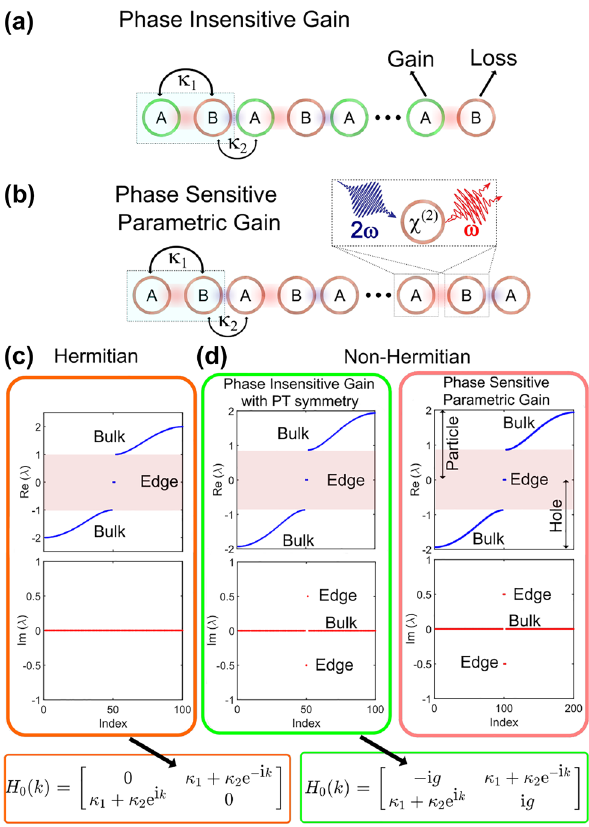
Figure 1: Topological edge-gain induced by parametric interaction. (a) Conventional topological edge-gain realized with alternate phase-insensitive laser gain and loss arrangement in a SSH chain of resonators. (b) Similar edge-gain can be implemented with uniform parametric gain in a SSH chain of nonlinear resonators, where the quadratic nonlinearity ( 𝜒 (2) ) couples the pump (2 𝜔 ) and the signal ( 𝜔 ) waves. (c) Eigenvalue diagram (real part (top) and imaginary part (bottom)) for a Hermitian SSH model showing the topologically protected edge mode lying within the bandgap. Edge-only instability is not possible in this case. (d) Eigenvalue diagram for a non-Hermitian setting realized either utilizing phase-insensitive gain (left) as shown in (a) or using the phase-sensitive parametric gain as shown in (b). The eigenvalue diagram depicts the edge-gain effect where the topologically protected mode has nonzero while the bulk modes have zero imaginary part, respectively. The momentum ) for the 1D Hermitian SSH and phase space ( k ) Hamiltonian ( H 0 insensitive gain ( g ) with PT symmetry SSH are also shown. Here, Index refers to a sequential label for the eigenvalues corresponding to the number of interacting resonators/OPOs ( N ).